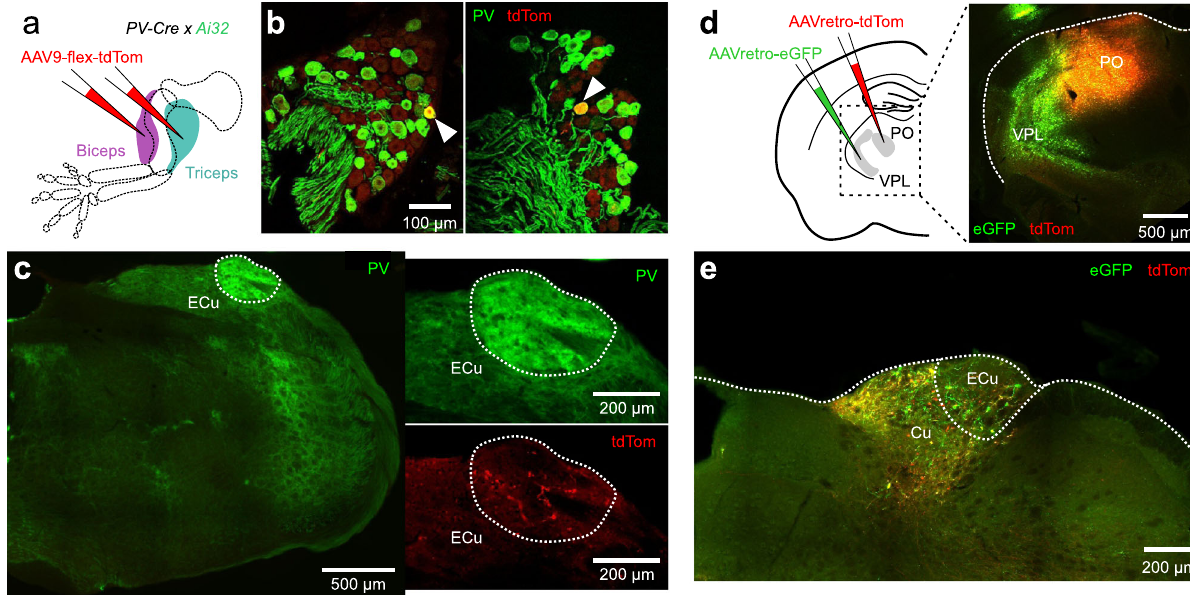
Fig. 1 | Forelimb proprioceptive afferents ascend to the mouse cortex via the cuneo-thalamic pathway. a Genetically restricted labeling of proprioceptive afferents from forelimb muscles with AAV9- fl ex-tdTomato in PV-Cre;Ai32 mice. b Con fi rmation of labeled PV+ cell bodies of primary sensory neurons in the cer- vicalDRG(arrows). c Centralbranchesofthelabeledpseudo-unipolarDRGneurons